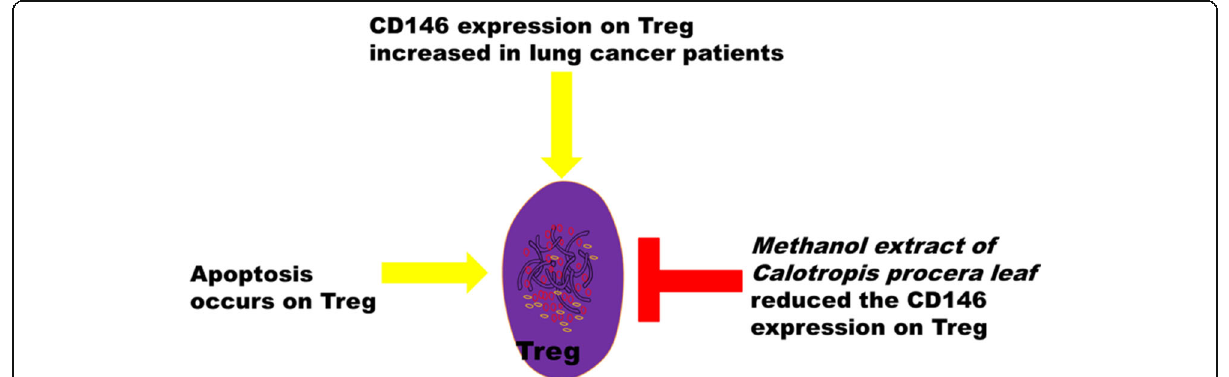
Fig. 8 Representation of Treg unveils activities of CD146, Calotropis procera and